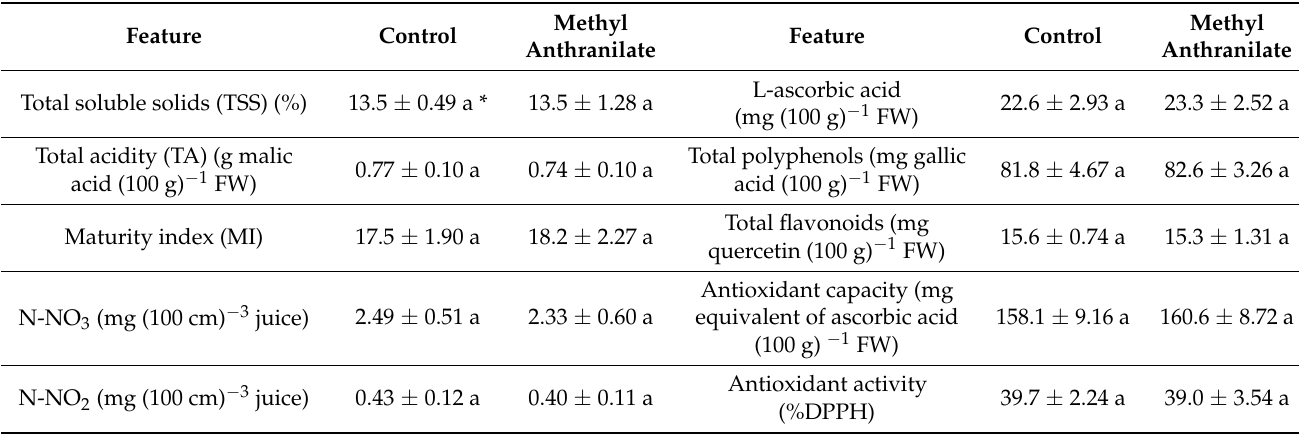
Table 1. The influence of methyl anthranilate on biochemical parameters and content of nitrates and nitrites in fruits of sweet cherry cv. ‘Burlat’.